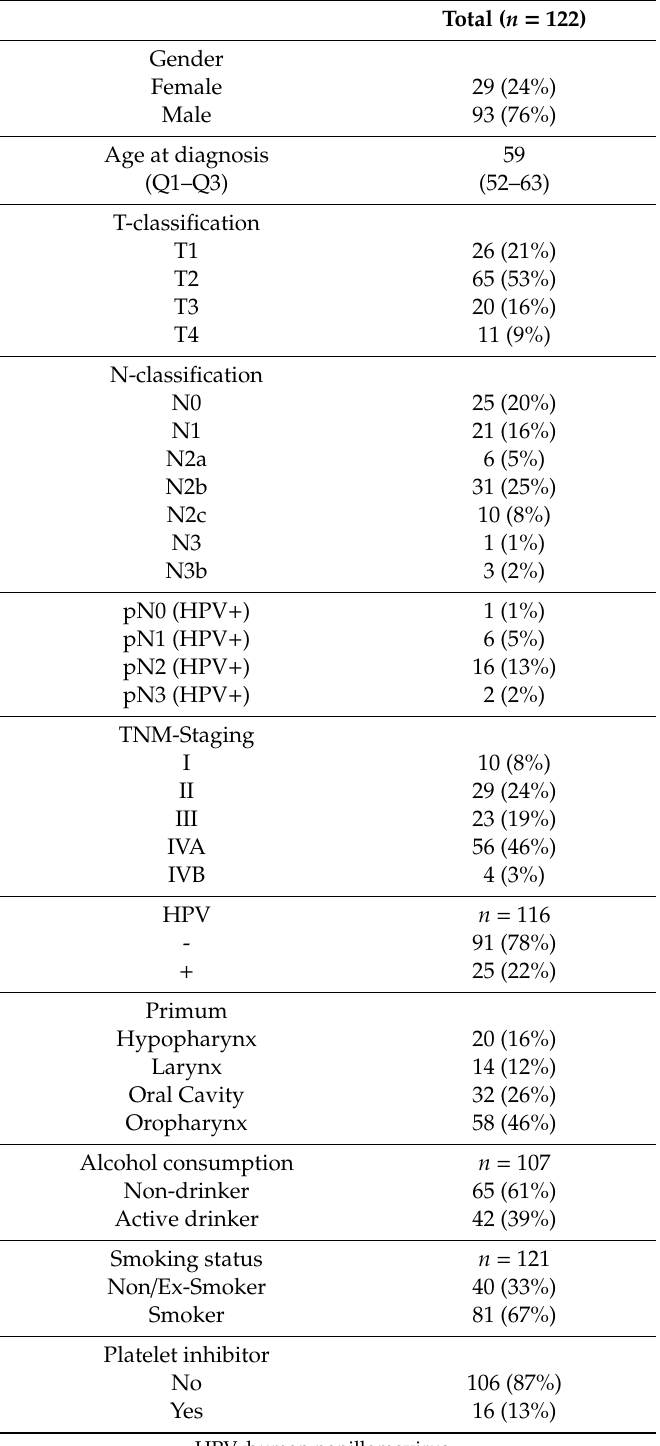
Table 1. Baseline characteristics of patients included in the